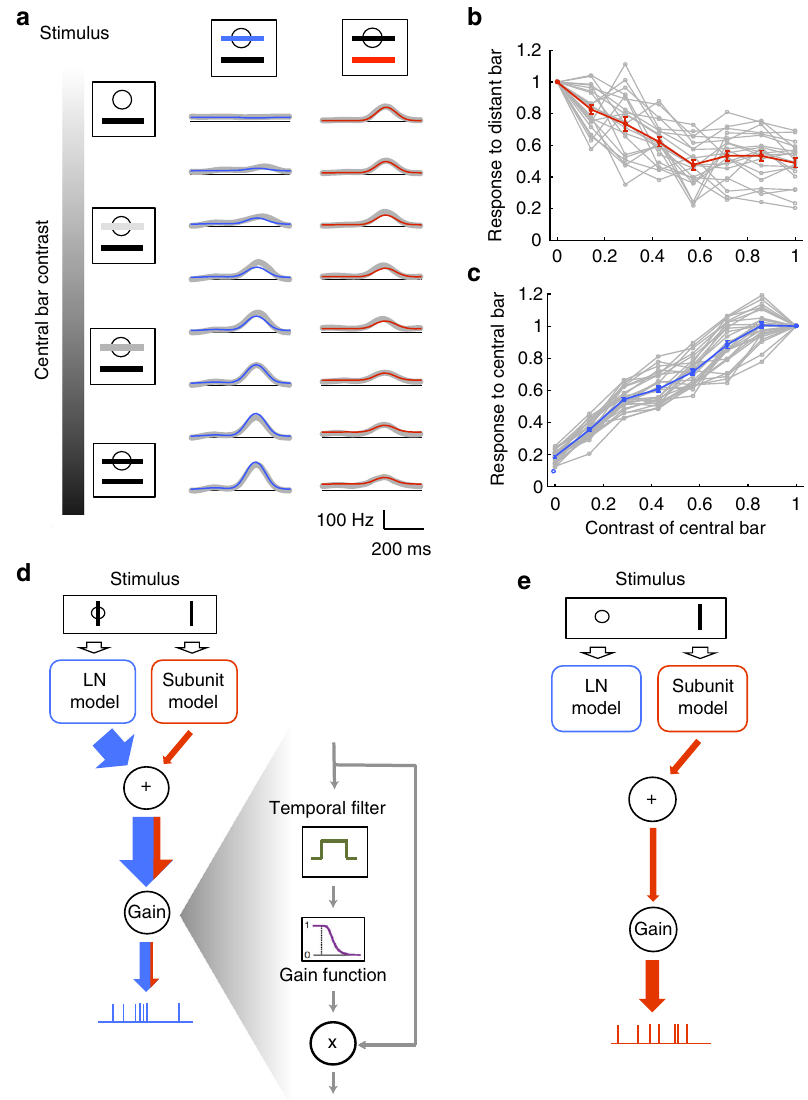
Fig. 5 A global gain control model explains gradual suppression of distant responses. a Gradual suppression of the response to the distant bar as central bar contrast increases. Left: schematic of the stimulus. The central bar contrast increased progressively from top to bottom. Middle: response of one cell to the central bar for eight different central bar contrasts; real PSTH (gray) and prediction of the gain control model (blue). Right: response of the same cell to the distant bar as contrast of the central bar increases; real PSTH (gray) and prediction of the gain control model (red). b Peak of the response to the distant bar (normalized by the response to the distant bar alone) as a function of the contrast of the central bar for individual cells (gray) and on average (red). Error bars represent SEM. c Peak of the response to the central bar (normalized by the response to the central bar alone) as a function of the contrast of the central bar for individual cells (gray) and on average (blue). Error bars represent SEM. d , e Schematic of the effect of gain control. In case of a central stimulation d , a gain control component will suppress the output; weak inputs from the surround will barely modulate the response. In case of no central stimulation e , the gain control component will enhance the weak inputs corresponding to the distant